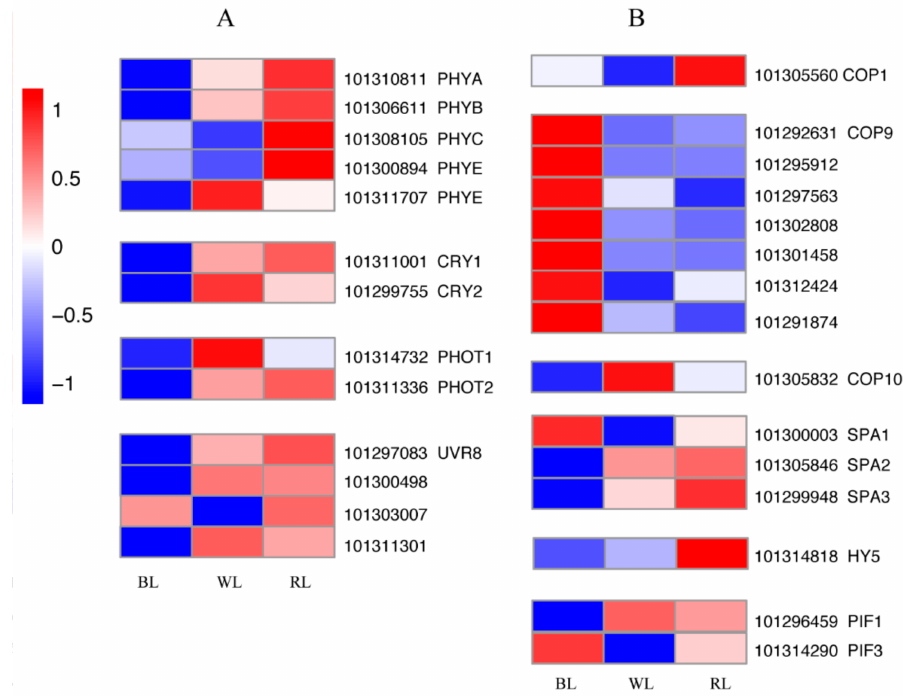
Figure 4. Heat map of gene expression involved in light signal perception ( A ) and transduction ( B ). The color scale at the left represents re-processed log10 (FPKM+1) using Pheatmap, representing the relative expression level. The expression variance for each gene is indicated by colors ranging from low (blue) to high (red). WL, RL, and BL indicates samples treated by white light, red light, and blue light,